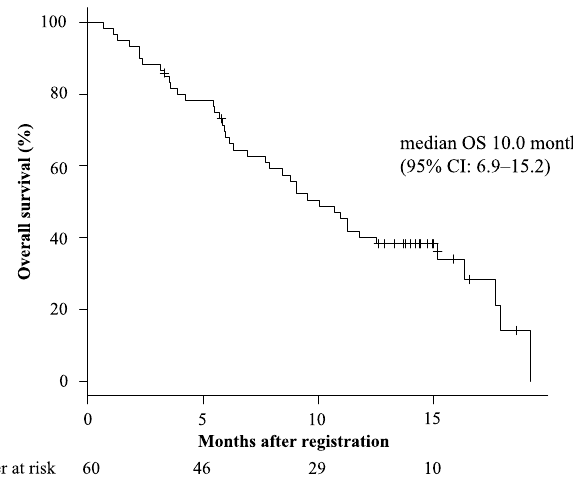
Figure 3. Overall survival (OS) during the study. CI confidence interval.